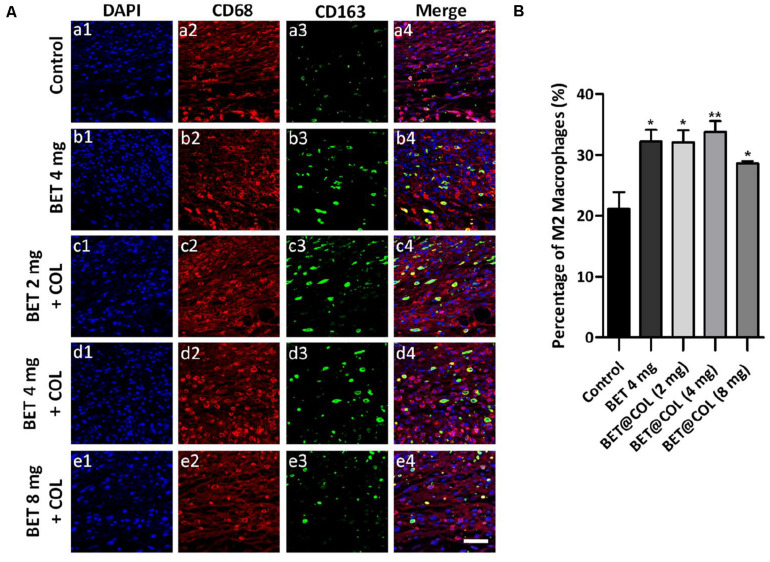
Betaine promoted M2 macrophages polarization in wounds on day seven. (A) Fluorescence photomicrographs of M2 macrophages of the control, free betaine solution treated and BET@COL treated wounds. Scale bar is 50 μm. (B) Quantitative result of immunofluorescence staining, n > 5. BET, betaine; COL, collagen. Statistical differences were performed using ANOVA. **p < 0.01, *p < 0.05, compared to control group.